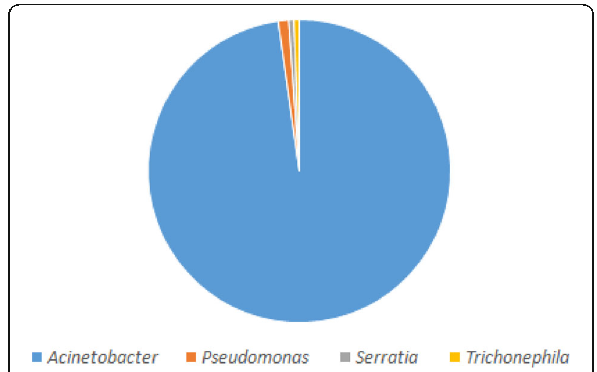
Fig. 6 Similarity pie diagram of MurE from A . baumannii and its related sequences from various genus obtained from PSI-BLAST search against